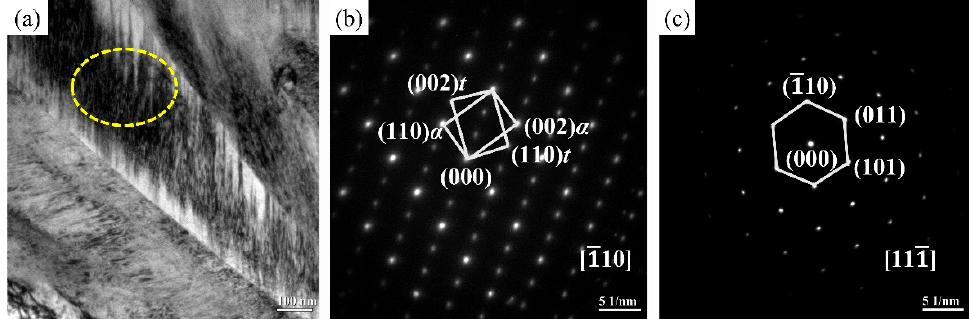
Figure 3. TEM characterization of the twinned martensite in the experimental steel: ( a ) bright field image; ( b ) selected area electron diffraction pattern of the sample tilted [ 1 (cid:3364) 10]; ( c ) selected area electron diffraction pattern of the sample tilted [ 111 (cid:3364) ].